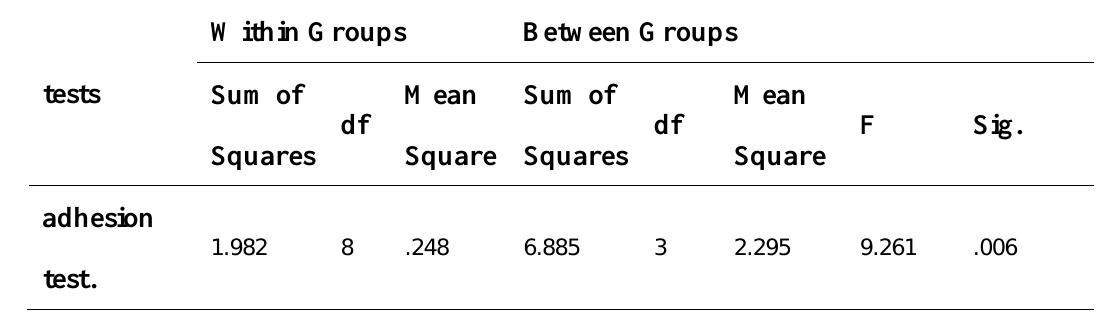
Table 5: ANOVA test of adhesion test